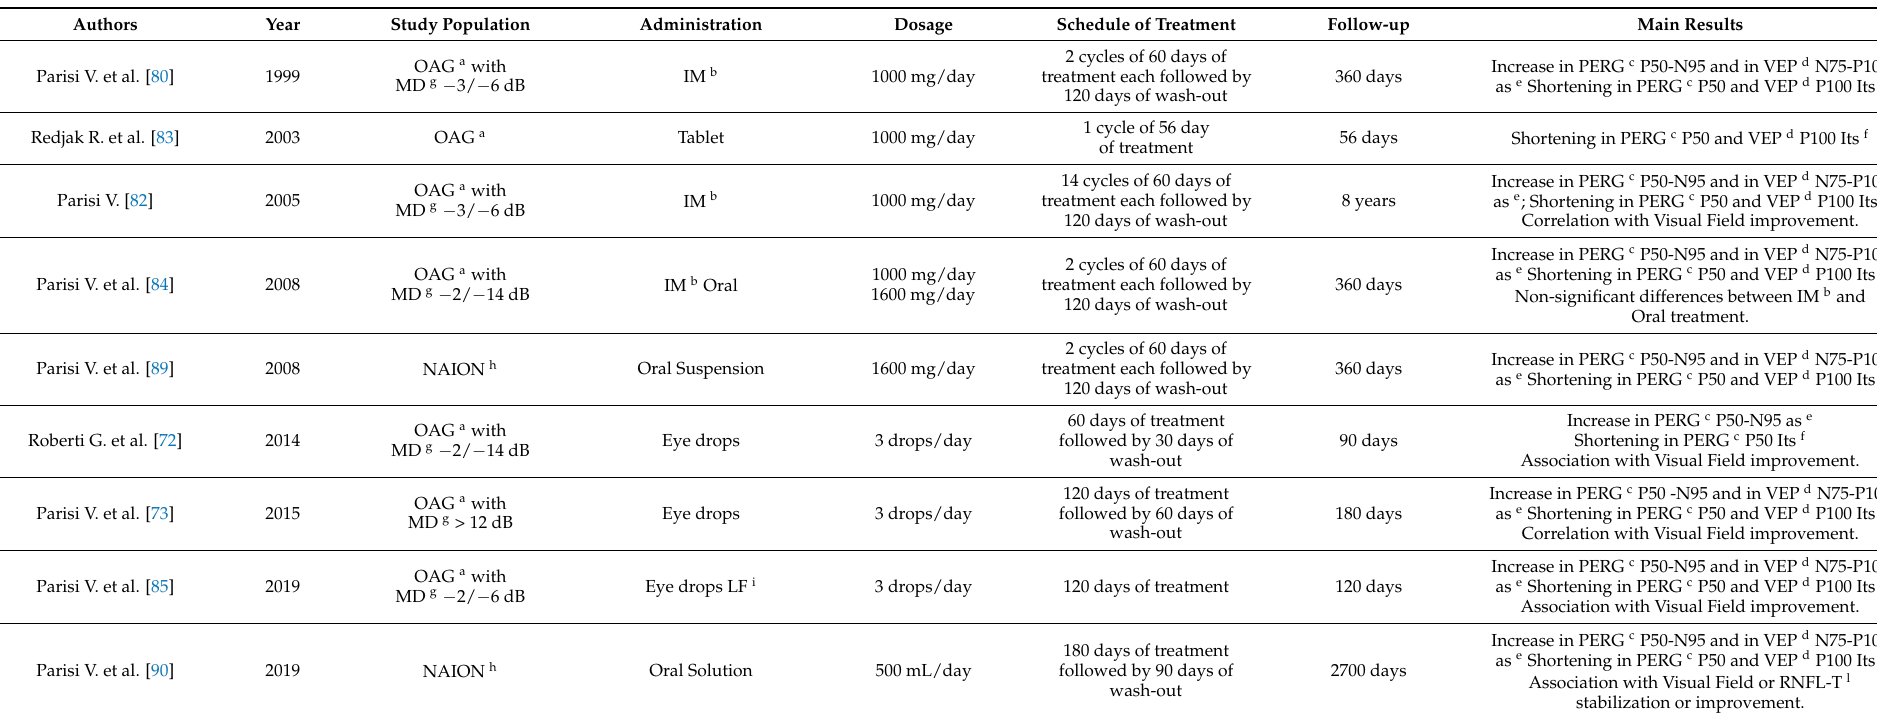
Table 2. Summary of clinical studies evaluating the effects of Citicoline in human ophthalmological neurodegenerative disease: electrophysiological